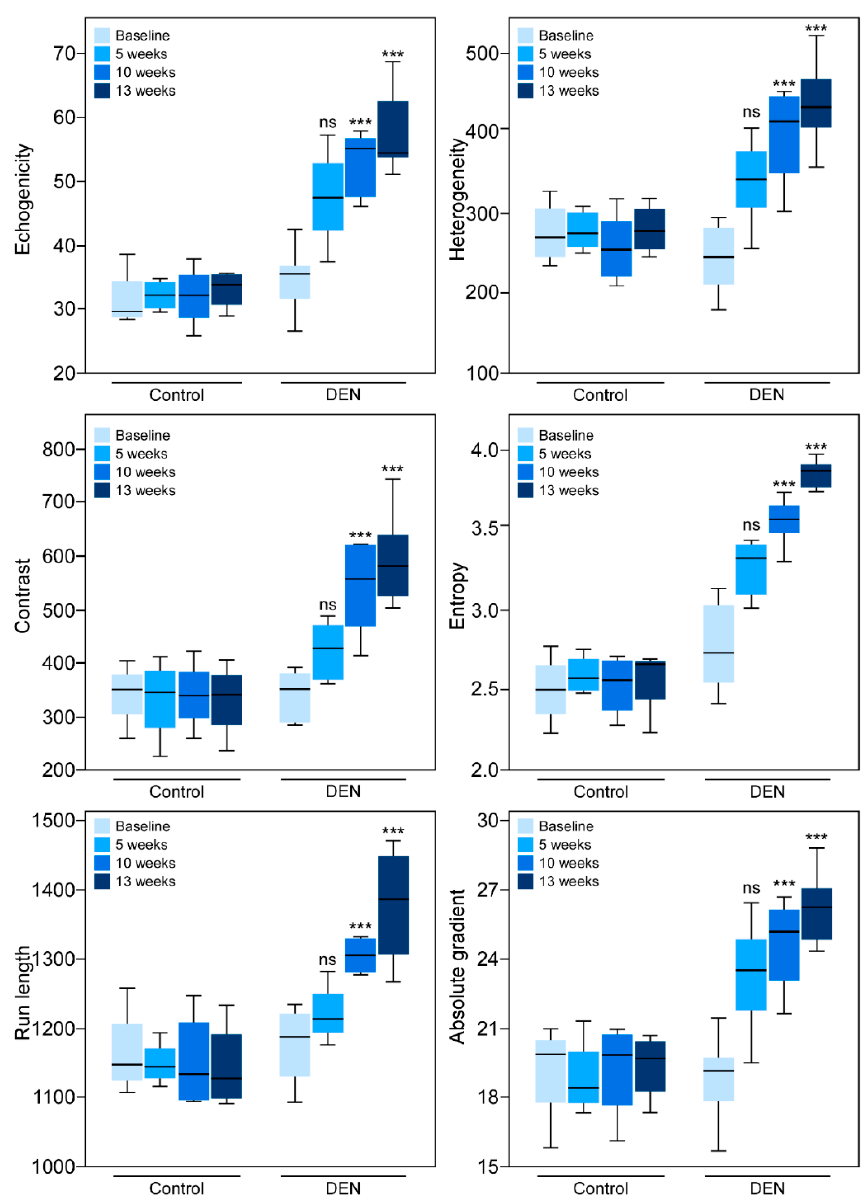
Figure 4. Analyses of texture features in hepatic B-mode ultrasound images. Boxplots showing distribution of six texture feature values (echogenicity, heterogeneity, contrast, entropy, run length, and absolute gradient) obtained from ultrasound image analyses taken either prior to the ingestion of DEN (baseline) or 5, 10, and 13 weeks after DEN administration. The texture features were determined from the images exported from the scanner in ti ff format. Distributions of the data points with the minimum, first quartile, median, third quartile, and maximum are shown for each group. The horizontal line inside the box is the median. Note that as the hepatic fibrosis developed there were statistically significant increases in each of the parameters 10 and 13 weeks after the commencement of DEN administration. Control rats showed no increase in the texture features over time. The ANOVA p -values between baseline and 10 weeks and baseline and 13 weeks for all the six texture features were less than 0.0001. Statistical significance was assigned as *** for p ≤ 0.001, and ns for non ‐ significant.